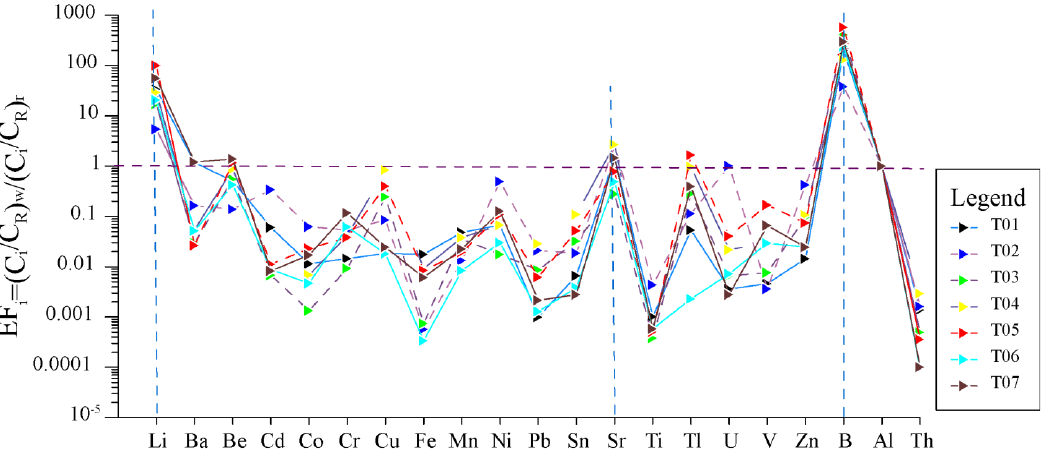
Figure 4. Enrichment factors of trace elements in hot springs along the TNR.